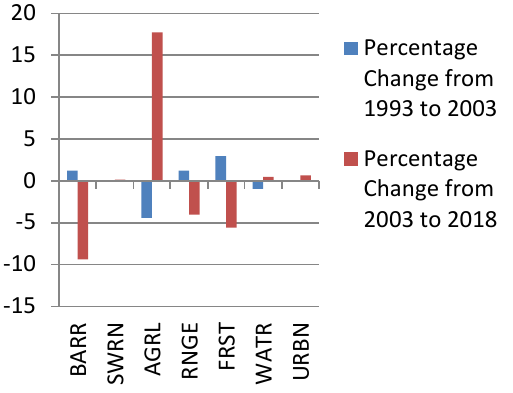
Figure 10 Percentage changes of LULC from 1993 to